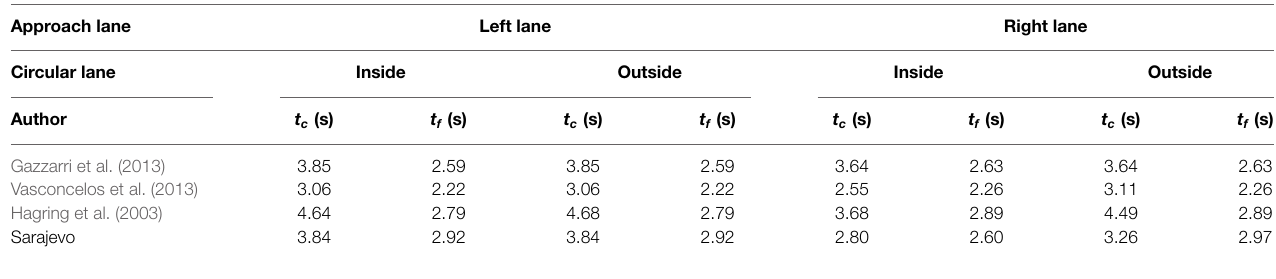
TABLE 2 | Gap acceptance parameters by different authors. Approach lane Left